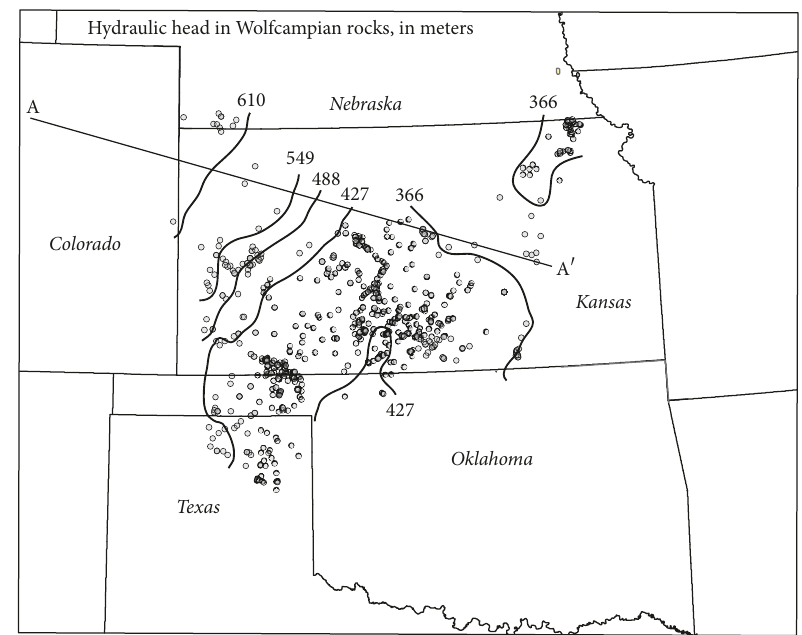
Figure 9: Map of potentiometric surface (hydraulic head contour lines in meters) in rocks of Wolfcampian age, after Nelson et al. ([7], Figure 14A). Hydraulic head ranges from less than 366 m in water wells in northeastern Kansas to greater than 610 m in oil and gas wells in eastern Colorado and southwestern Nebraska. Dots represent well control. Control data for the hydrologic model were taken along 800 km line A-A 󸀠 .